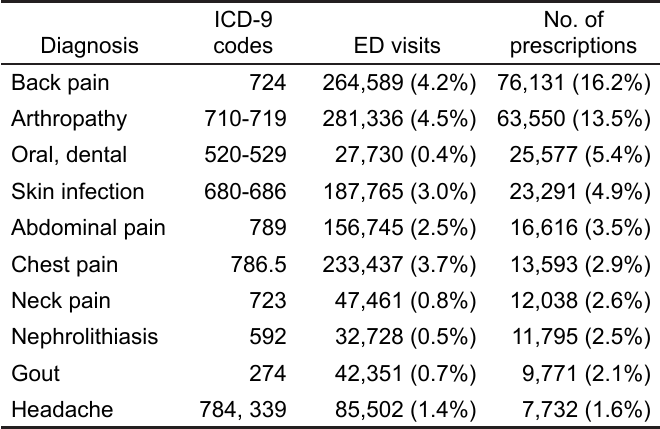
Table 3. Top diagnoses resulting in a hydrocodone/ acetaminophen